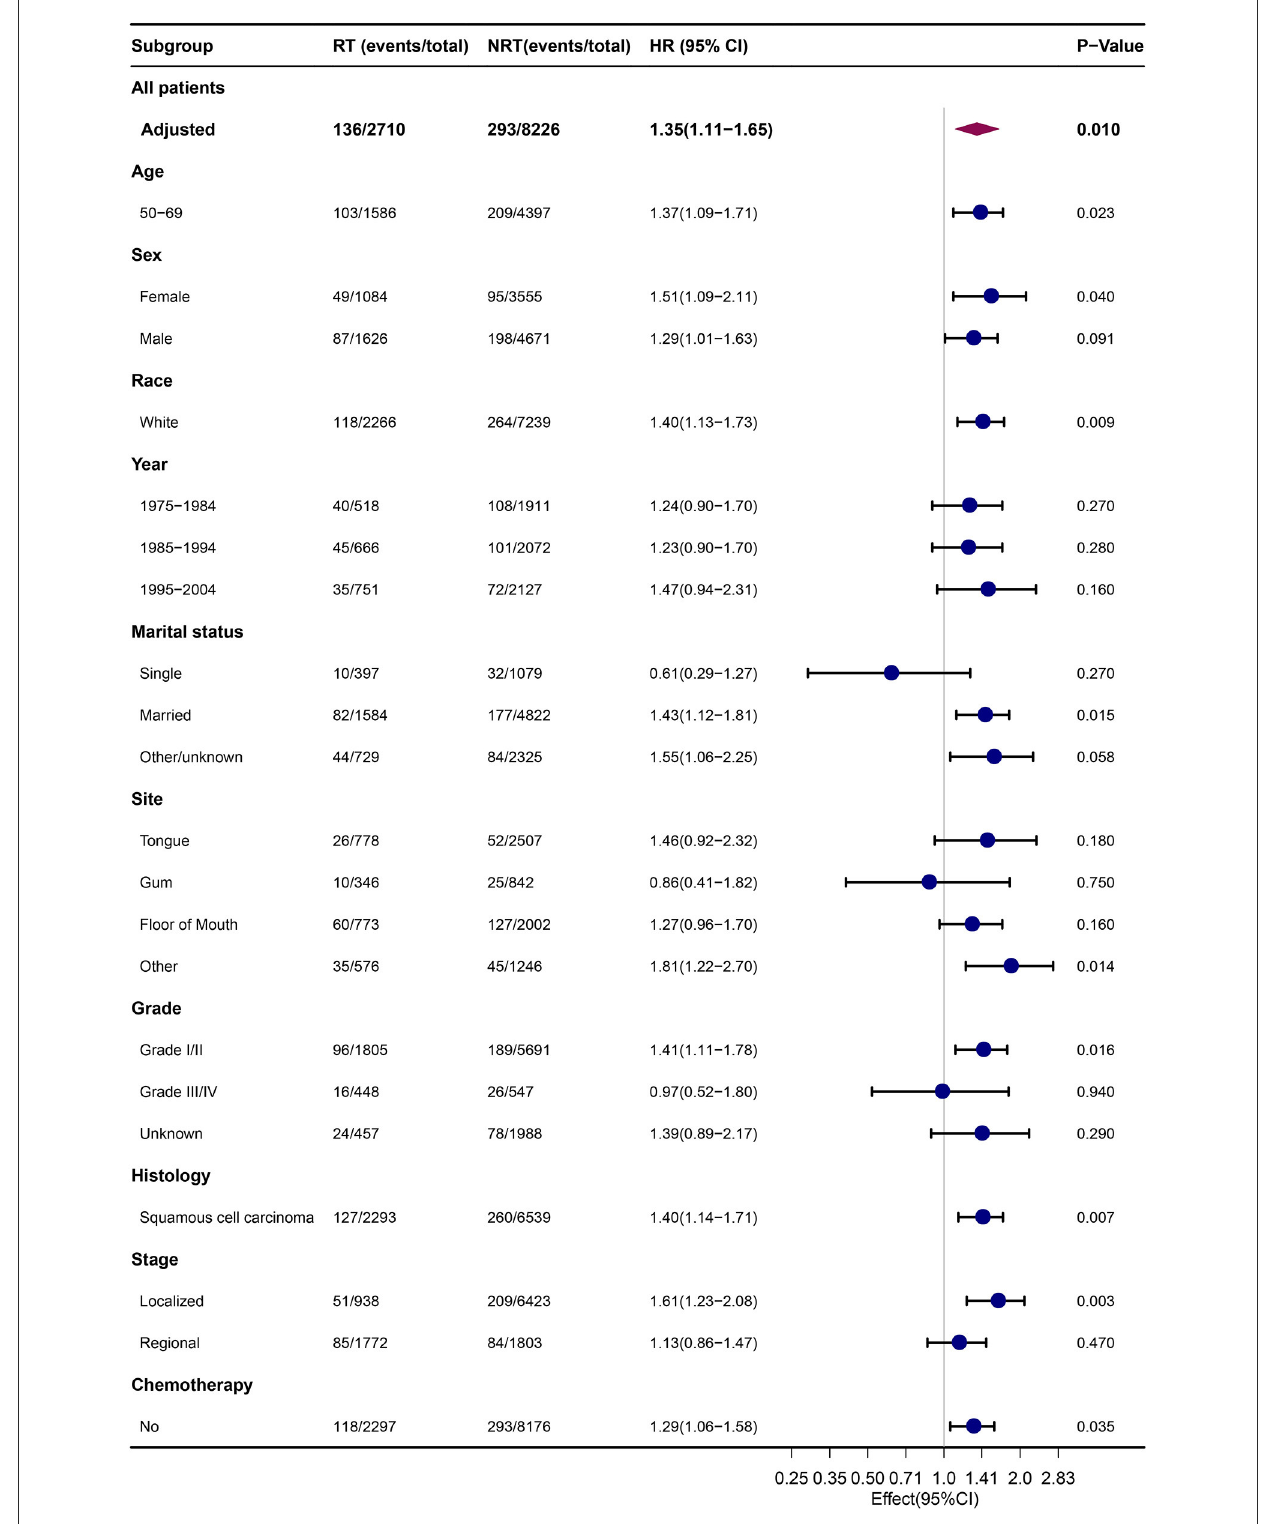
FIGURE2 Comparison of risk of SLC between subgroups by estimating HRs through competing risk analyses. NRT, no radiotherapy; RT, radiotherapy; HRs, hazard